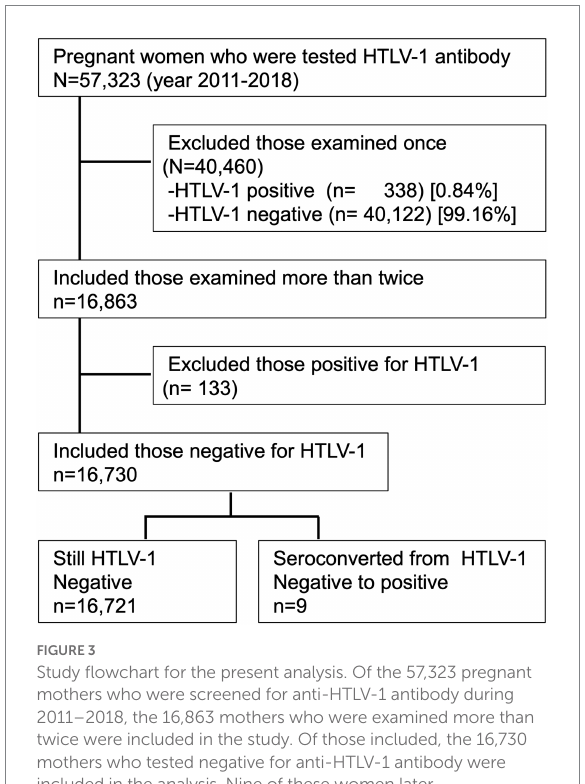
mothers who were screened for anti-HTLV-1 antibody during 2011–2018, the 16,863 mothers who were examined more than twice were included in the study. Of those included, the 16,730 mothers who tested negative for anti-HTLV-1 antibody